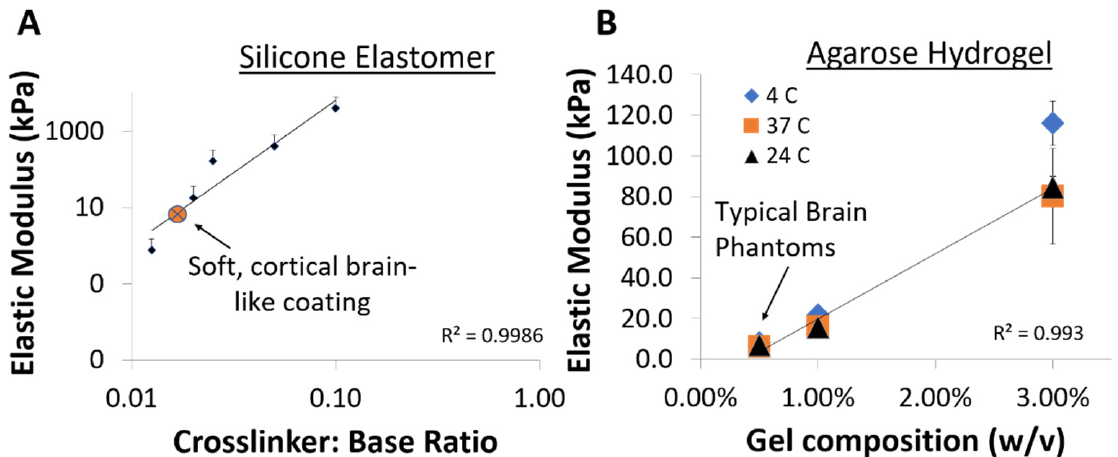
Figure 1. Estimated elastic moduli for various compositions of ( A ) silicone/nanotube elastomer and ( B ) agarose-based hydrogel compositions. The stability of the agarose gel compositions did not significantly change between 4 ◦ C and 37 ◦ C. The gel and elastomer compositions that mostly closely match the elastic modulus of cortical brain tissue is shown with an arrow. Mean ± standard deviations are shown.